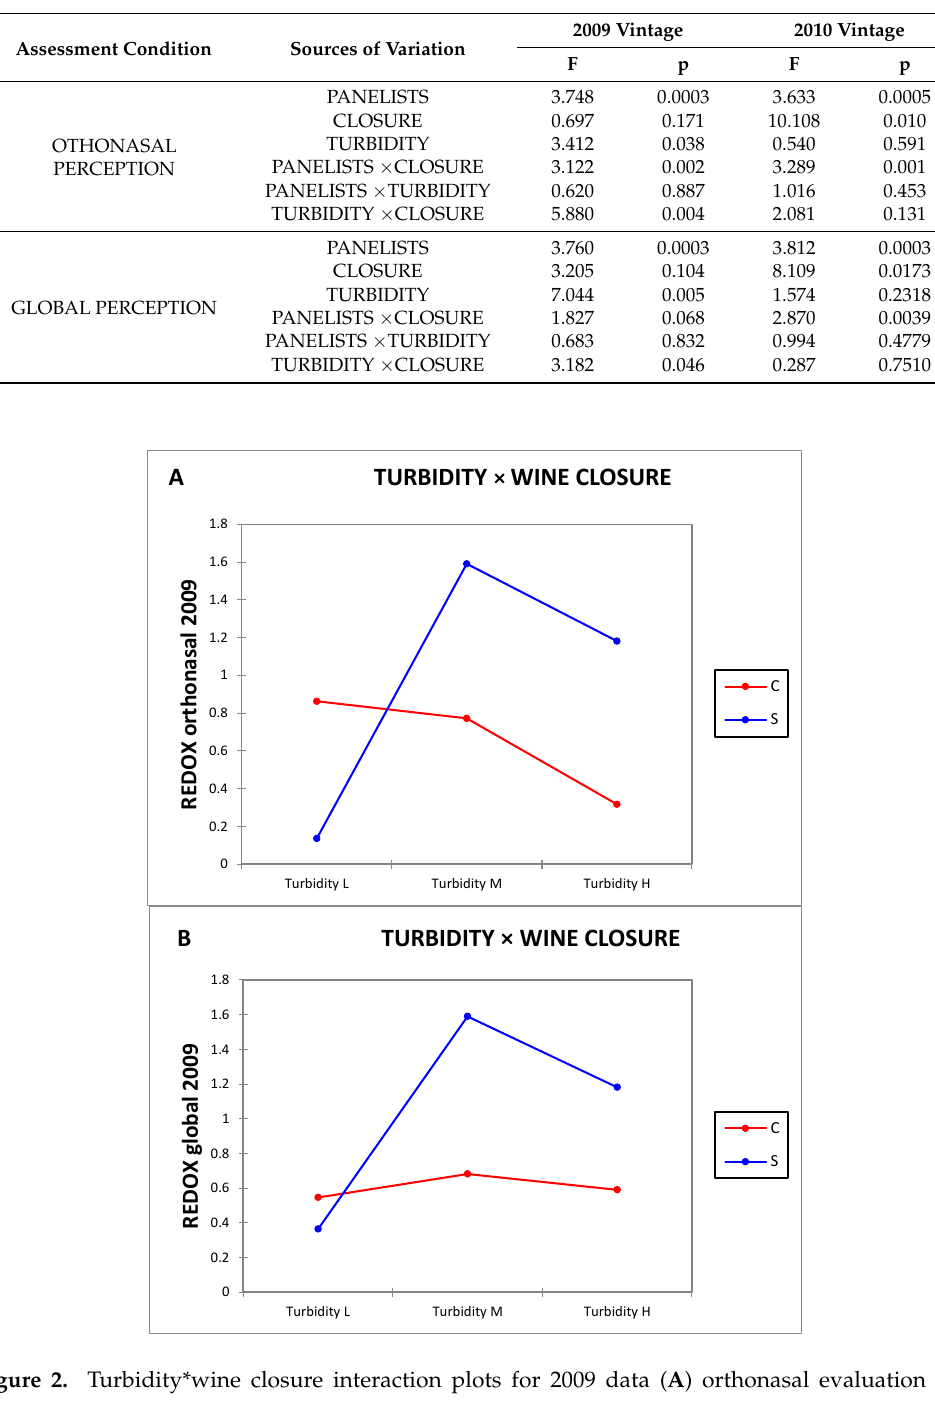
Table 4 shows the results of the post-hoc mean comparison for Closure type and Turbidity level. Wines closed with synthetic cork showed significantly higher sensory oxidation than wines closed with screw caps, but only for 2010 samples. Table 3. Summary of the significance level of the ANOVAS performed on the orthonasal and global REDOX odor scores for the 2009 and 2010 samples. Probabilities in bold are significant at α = 5%.